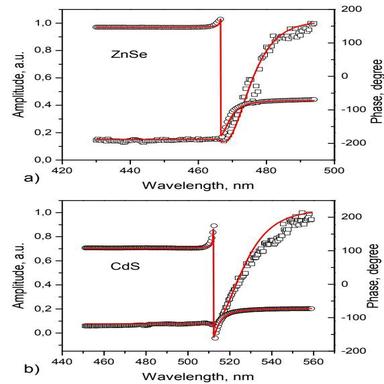
The normalized amplitude (squares) and the phase (circles) of the PPES signal for ZnSe (a) and CdS (b) crystals, respectively, measured at the modulation frequency of 10 Hz. The points refer to the experimental data, and the red lines are theoretical fittings performed with Eq. and obtained by applying the least square method.